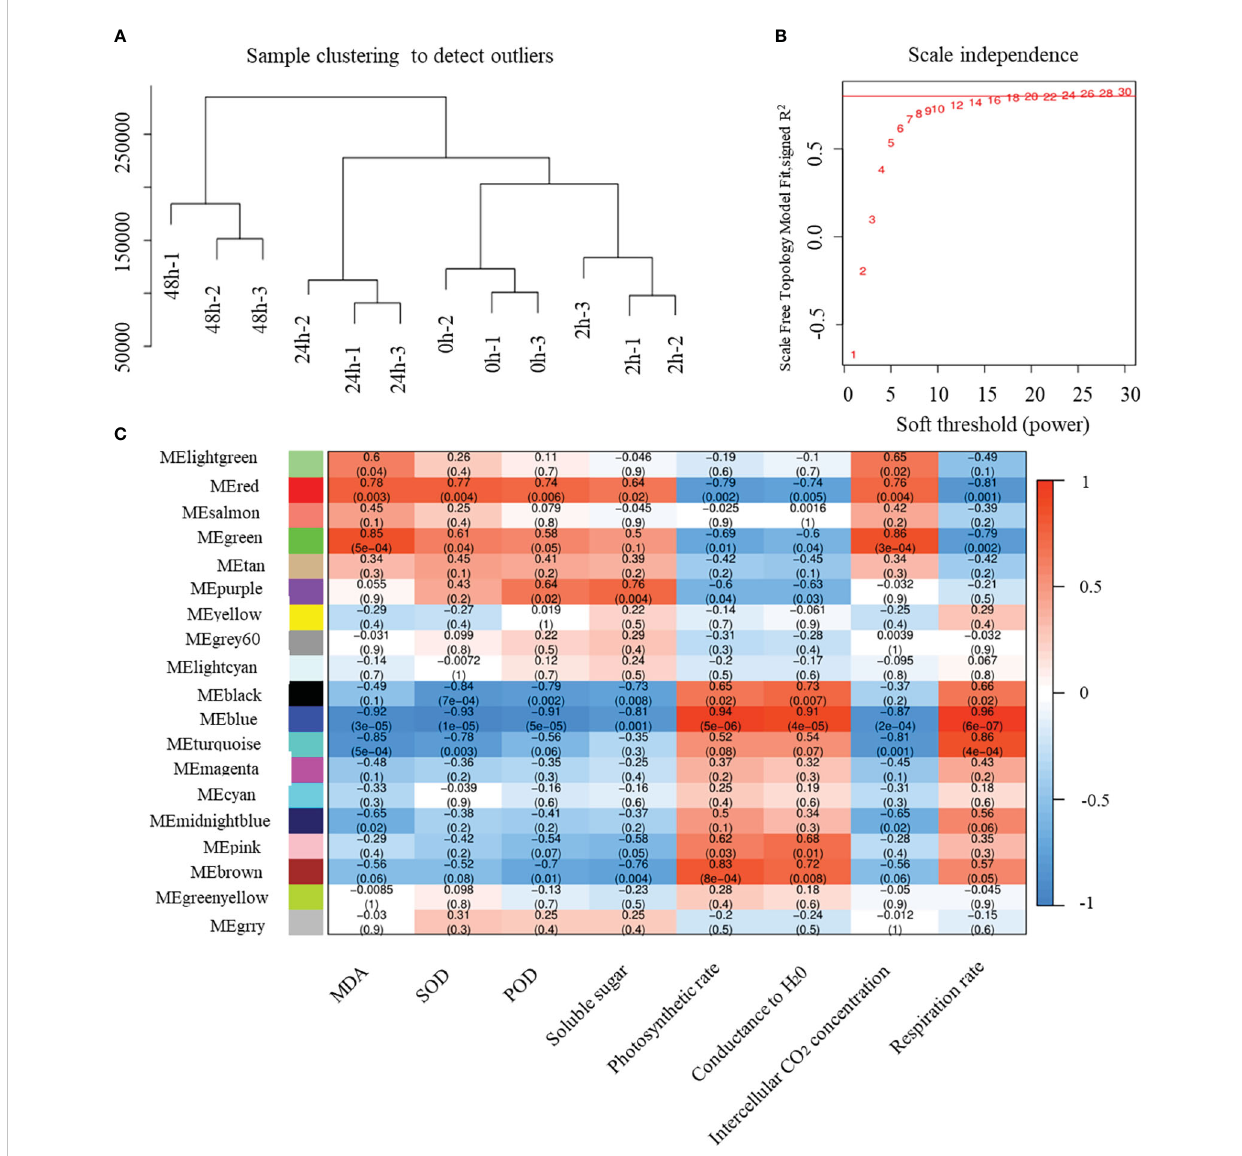
FIGURE 6 Results of WGCNA based on the gene expression level and phenotypic data. (A) Results of sample clustering; (B) results of scale independence, candidate power was from 1 to 30; (C) relationship of different modules and cold resistance-related traits. Numbers in the box represent the correlation coef fi cient, and the number in the brackets represent the corresponding p -value. The color scale represents correlation coef fi cient from 1 (red) to -1